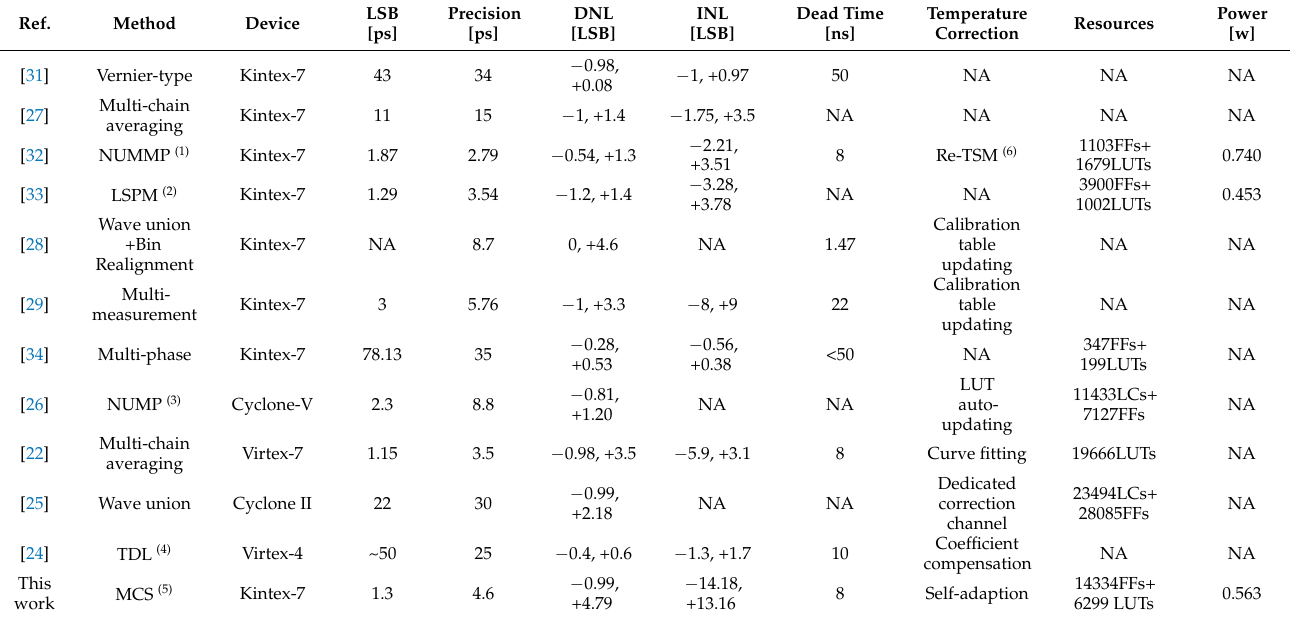
Table 2. FPGA-TDC performance